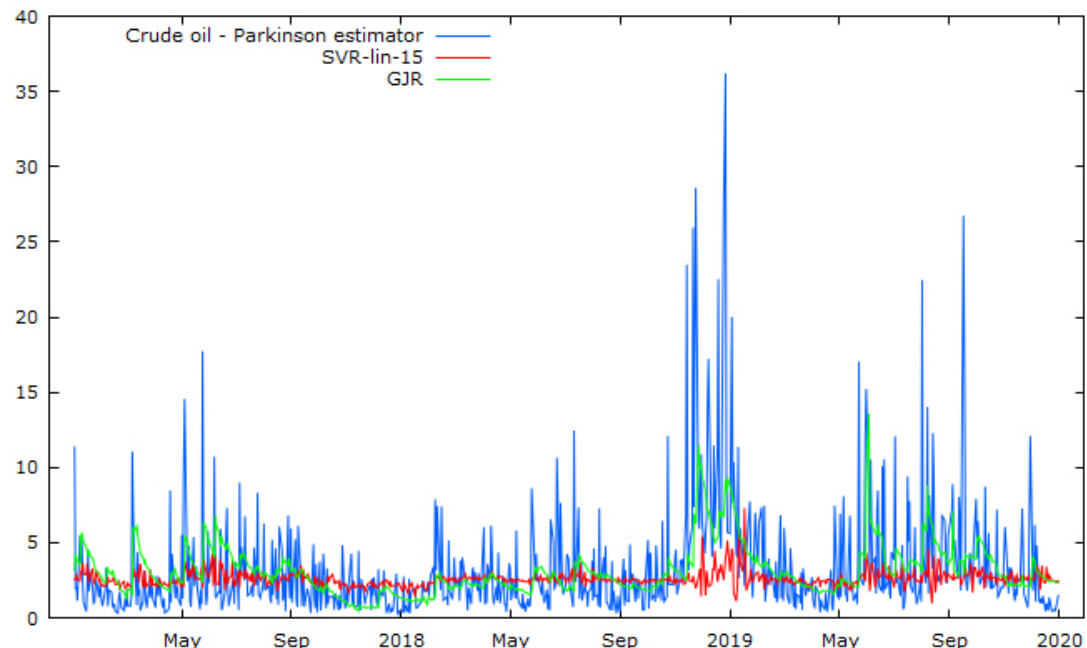
Figure 3. One-day-ahead volatility forecasts and values of the Parkinson estimator for crude oil.